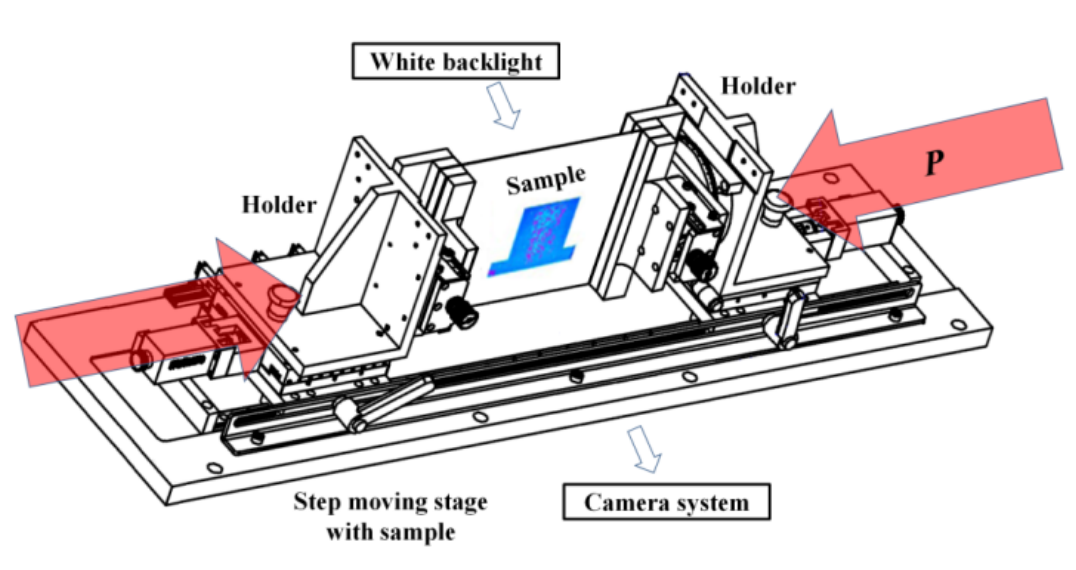
Figure 9. The expression of the sensitivity of the 3DS sensing patch. A saturation followed the linear